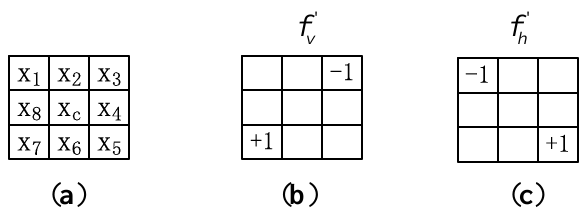
Figure 3. Illustration of 45°-direction analysis. ( a ) 3-square neighbor. ( b ) Vertical filter of LDC in 45° rotation. ( c ) Horizontal filter of LDC in 45°